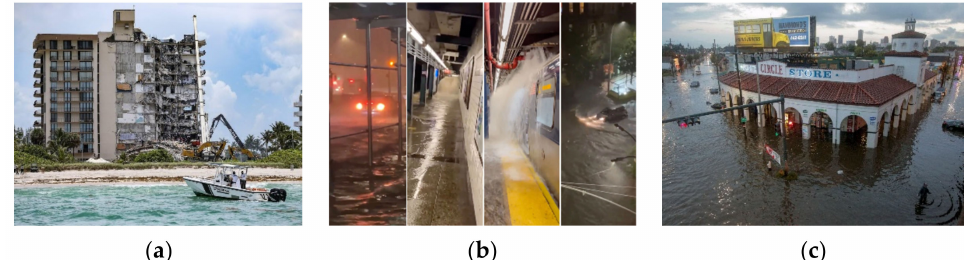
Figure 1. ( a ) Condominium collapse in Miami due to flooding (Courtesy of: Miami Herald); ( b ) Sub- way/streets flooding in New York City due to Hurricane Ida (Courtesy of: New York Post); ( c ) New Orleans flash flood (Courtesy of: Washington Post).